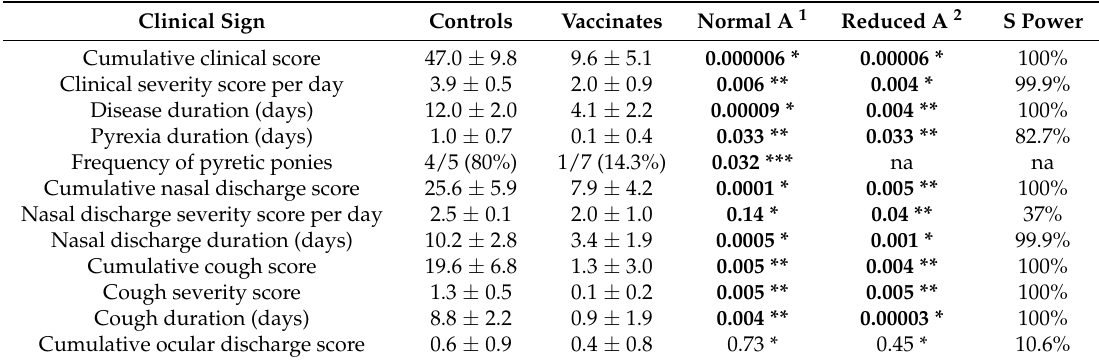
Table 2. Tetanus toxoid antibody titres, expressed as international units (IU)/mL.